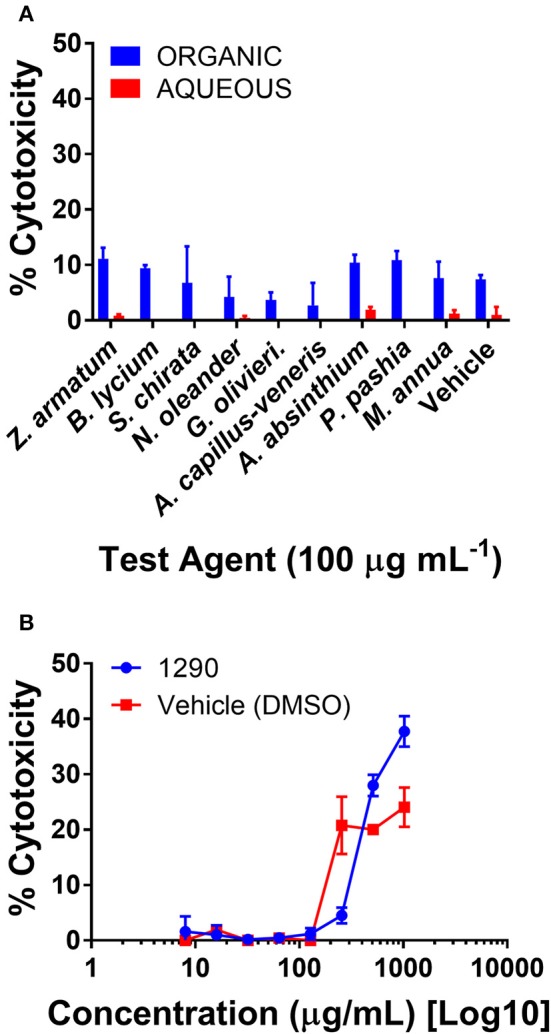
Cytotoxicity of extracts in a human keratinocyte (HaCaT) cell line by LDH assay for cell viability. (A) Organic and aqueous extracts were screened at 100 μg mL−1. Significance was determined in comparison to the vehicle control (DMSO), with *p < 0.05, **p < 0.01, and ***p < 0.001. (B) Extract 1290 was examined by dose response study from 8 to 1,024 μg mL−1.